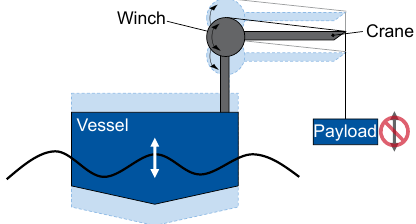
Figure 1: Simplified schematic of an AHC offshore crane